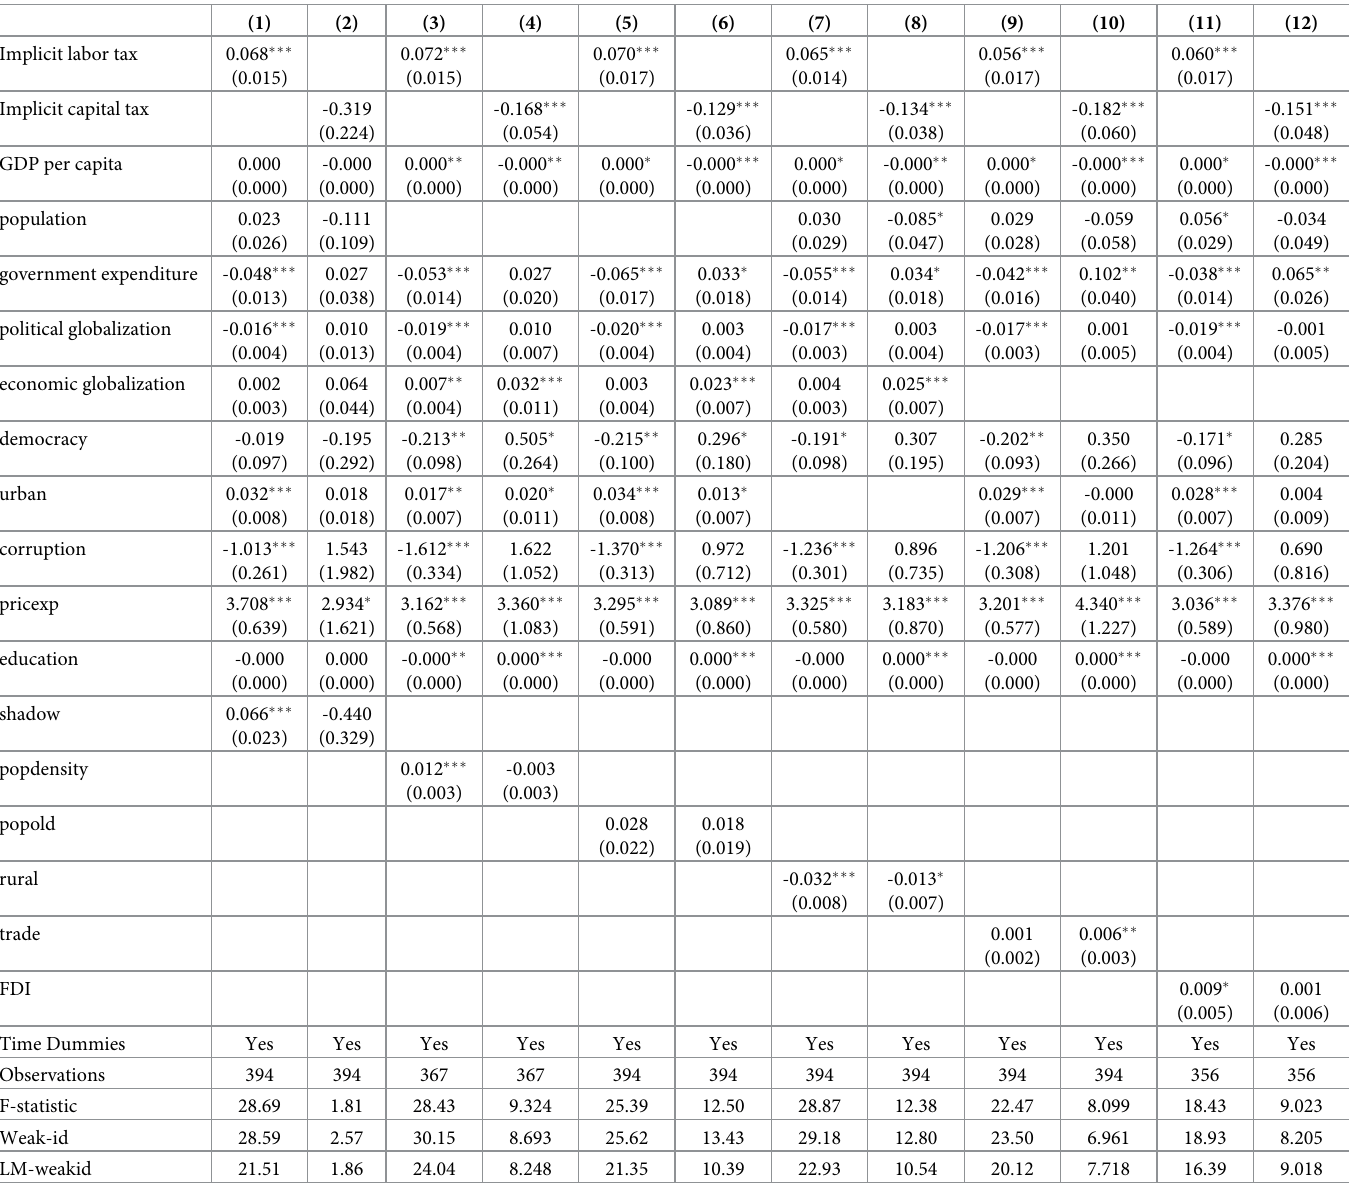
Table 8. The impact of implicit taxation on economic sophistication: Robustness